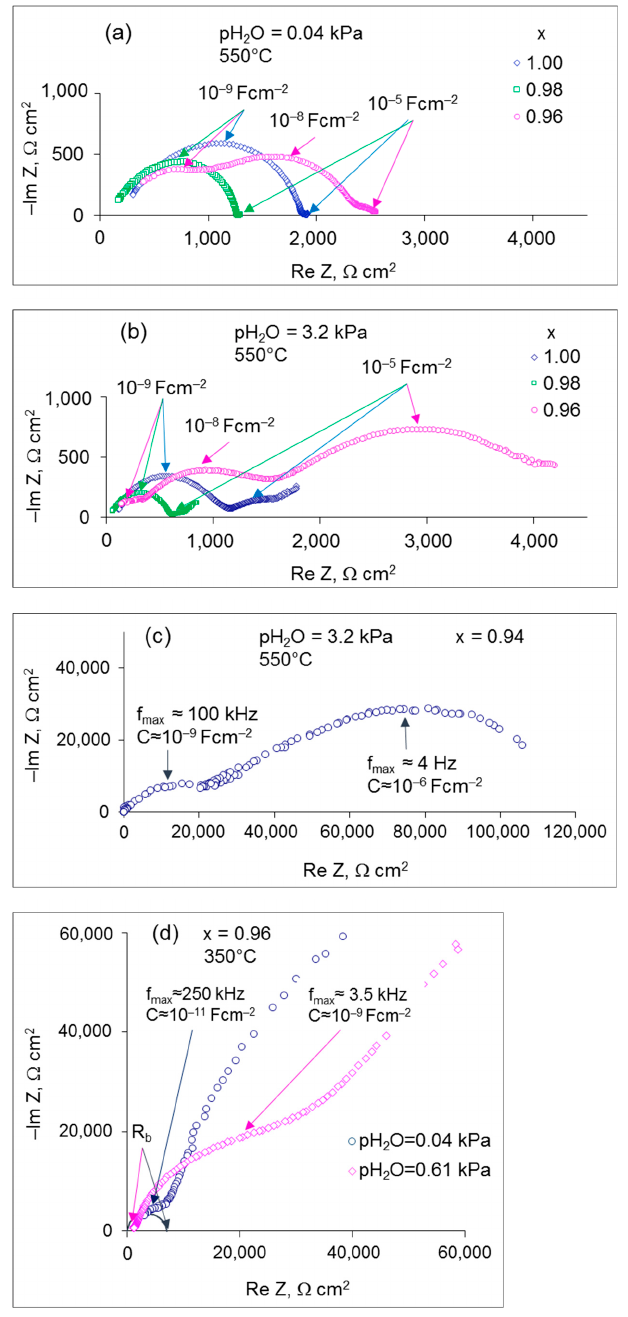
Figure 3. The impedance spectra for x = 0.96, 0.98 and 1.00 samples measured at 550 ◦ C under ( a ) pH 2 O = 0.04 kPa and ( b ) 3.2 kPa; ( c ) x = 0.94, pH 2 O = 3.2 kPa, 550 ◦ C; ( d ) enlarged high-frequency fragments of the hodographs of the x = 0.96 sample at 350 ◦